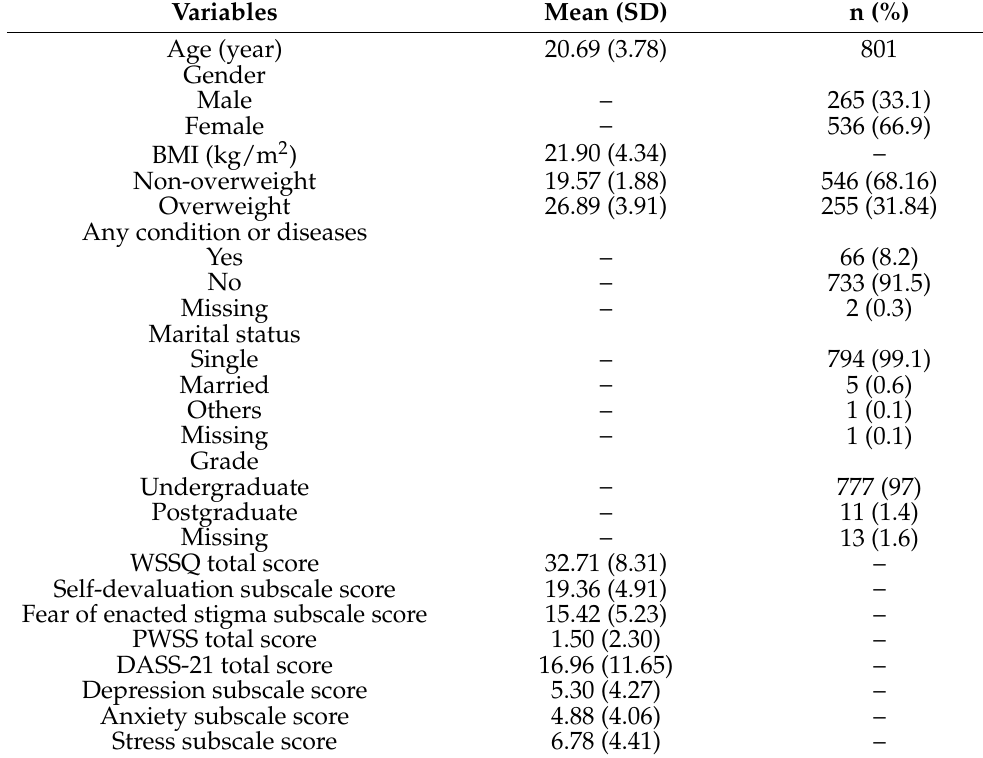
Table A1. Sample demographic (n =